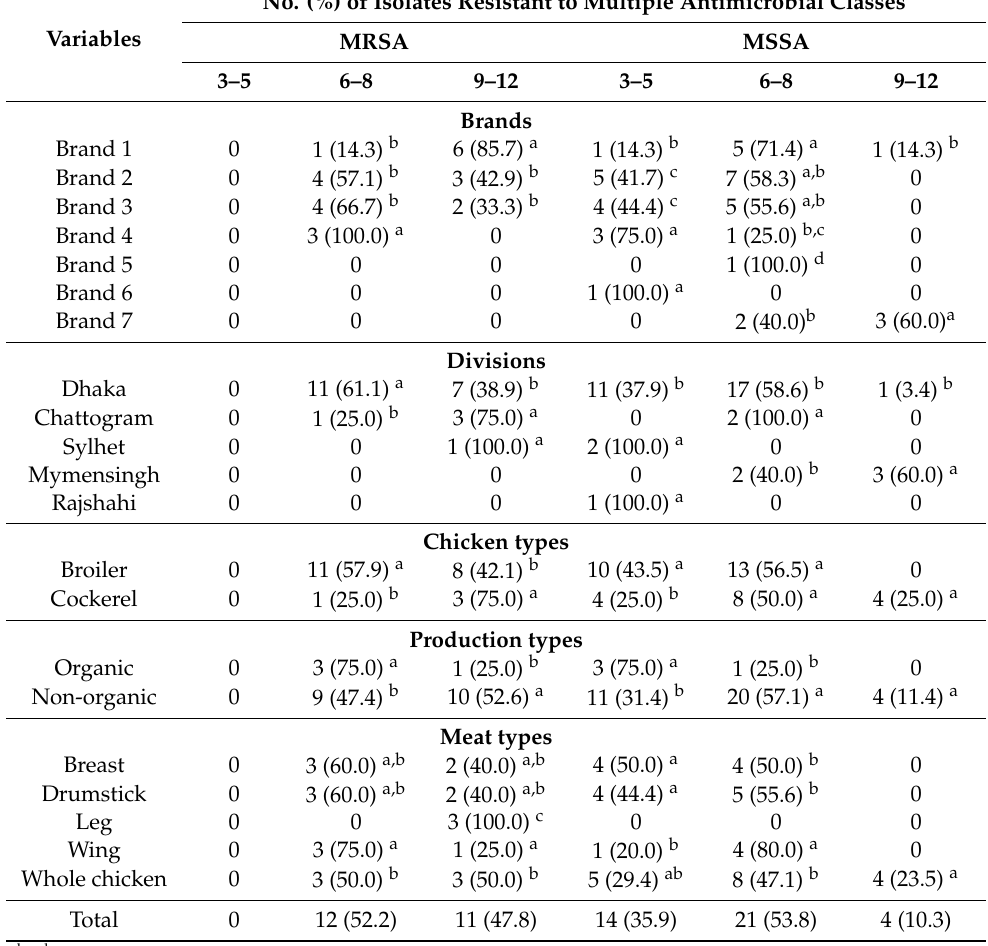
Table 2. Distribution of MRSA and MSSA isolates resistant to multiple classes of